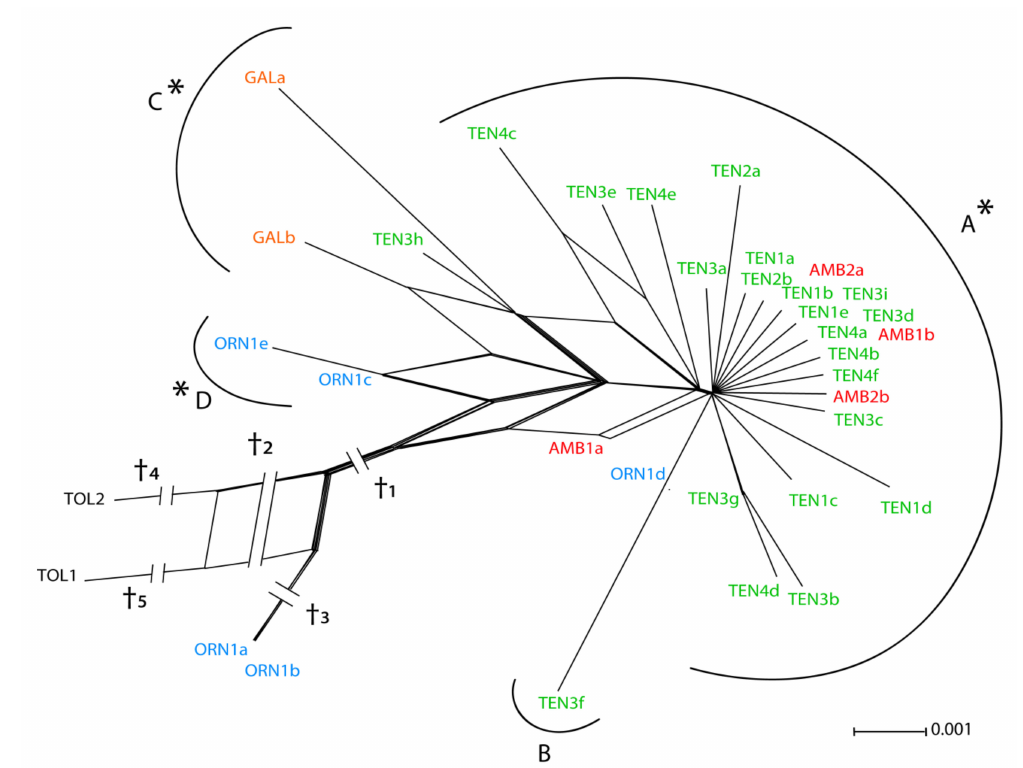
Figure 3. Neighbor-Net for the ETS region of Centaurea tentudaica. Letters correspond with the clades, shown in Figure S1. * indicates the statistically supported clades in the Bayesian analysis with a posterior probability above 0.90. † 1 = 0.025; † 2 = 0.004; † 3 = 0.031; † 4 = 0.004; † 5 =